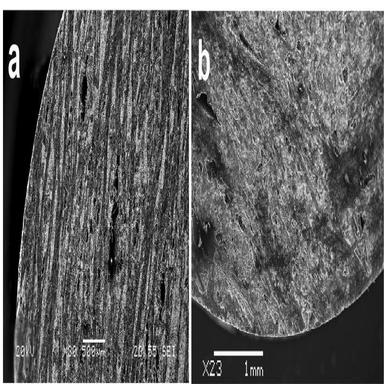
Low magnification SEM images of the bottom surface of the Cf-HfB2 powder composites after compressive testing across the plies. (a) Strongest sample (b) weakest sample.